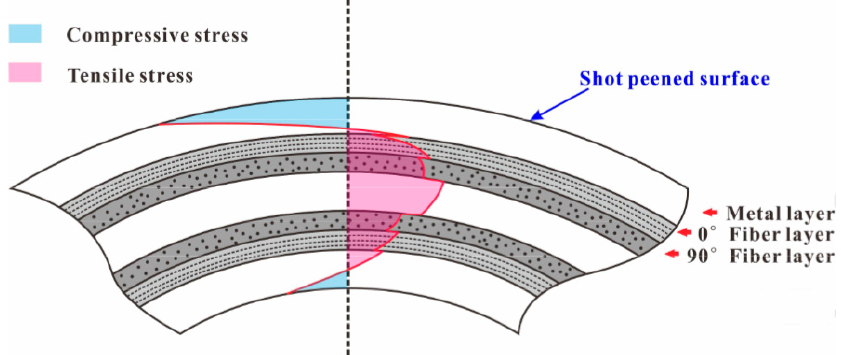
Figure 13. Distribution of residual stresses in shot peened NFML (reproduced with permission from [138]; copyright© 2021 Elsevier Ltd. All rights reserved.).